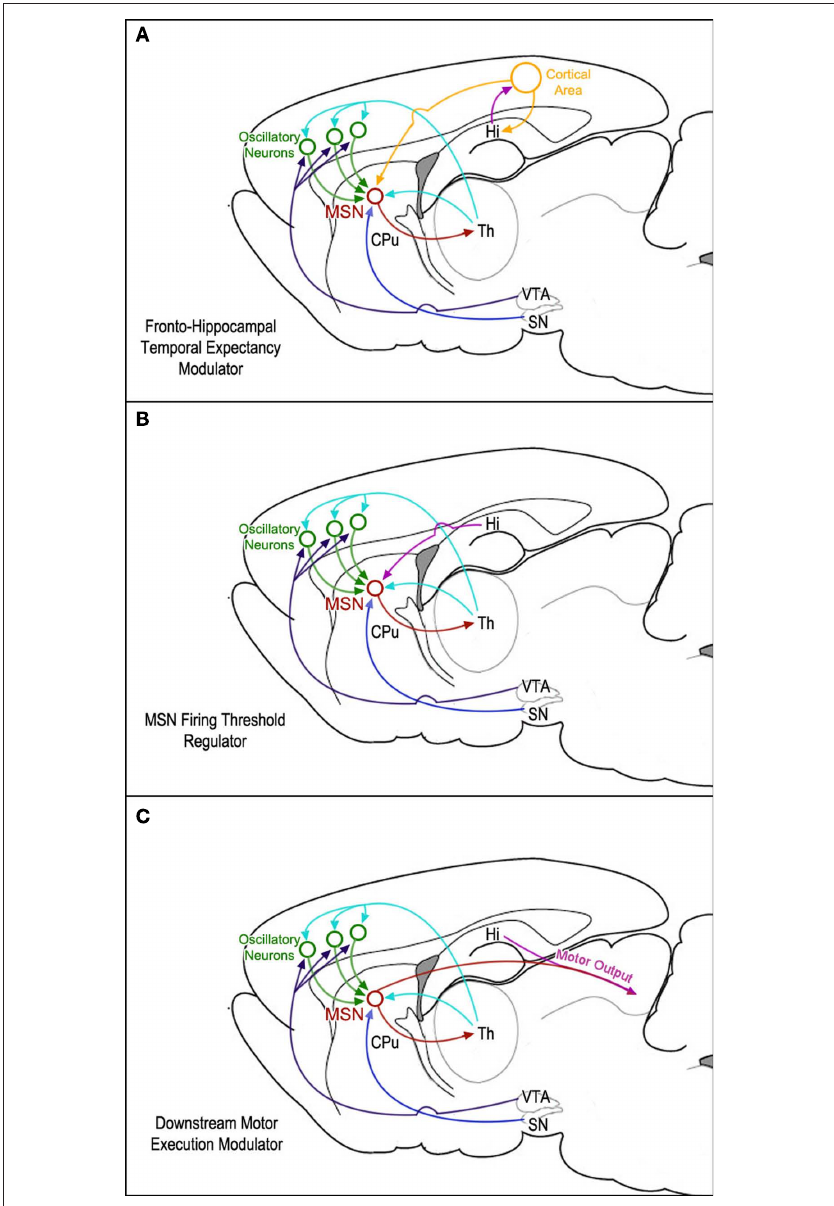
FIgure 2 | Diagrams of three possible mappings of functional hippocampal connectivity within the neural circuits proposed by the striatal beat-frequency (SBF) model of interval timing: (A) the hippocampus is involved in a feedback mechanism designed to update temporal expectancy with a separate cortical area. This area’s output is then integrated with clock and reward information by striatal medium spiny neurons (MSNs). (B) The hippocampus modulates MSN firing thresholds via either tonic inhibition or phasic excitation. (C) Hippocampal regulation downstream of the MSNs affects translation